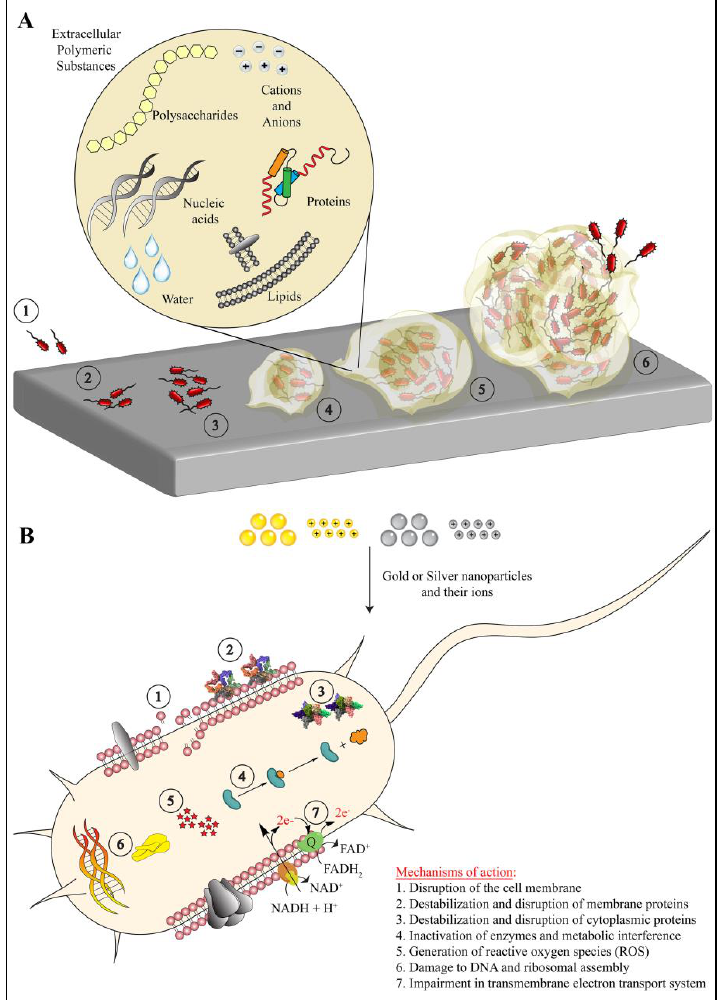
Figure 1. ( A ) The process of biofilm formation in which the bacterial cells approach a biological or non-biological surface (1), adhere firmly (2), multiply (3) and secret extracellular polymeric substances (4). Eventually, this whole mass (i.e., biofilm) grows (5 and 6) into a 3D complex structure that contains nucleic acids, polysaccharides, lipids, proteins, ions and water (magnified circle). ( B ) The mechanism of antibacterial action of gold nanoparticles, silver nanoparticles, and their respective ions, which act on seven specific targets in bacterial cells. The sizes of molecules and bacteria are not to scale, and they are represented arbitrarily for schematic representation